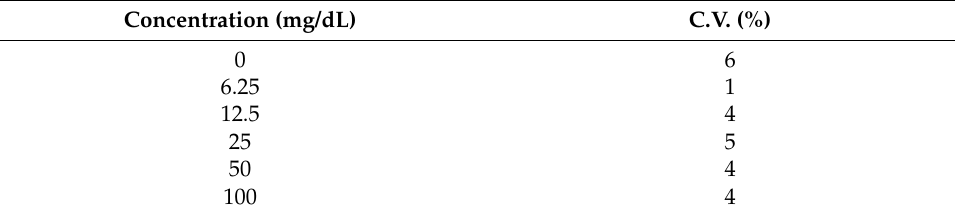
Table 1. Coefficient of variance (C.V.) results of different AcAc concentration at three repetition tests.